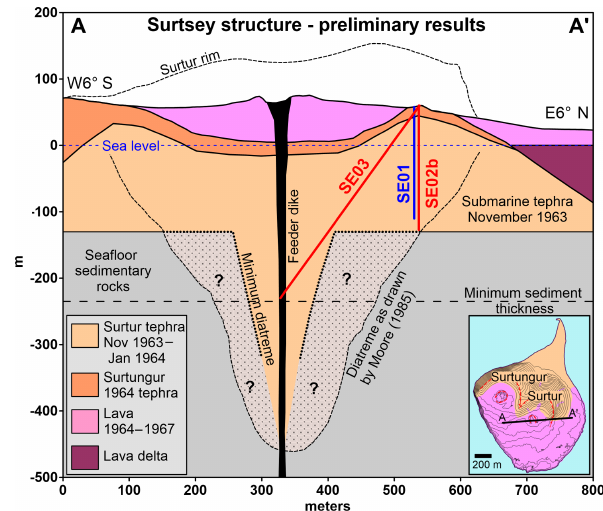
Figure 5. Structural sketch of Surtsey showing the minimum sub- surface diatreme required to fit to the drilling results and the Moore (1985) hypothesis. The minimum thickness of marine sedimentary rock below the pre-eruption seafloor is 100m, based on seismic re- flection results from Thors and Jakobsson (1982). The advance of basaltic lava flows in 1964–1967 produced the lava delta.